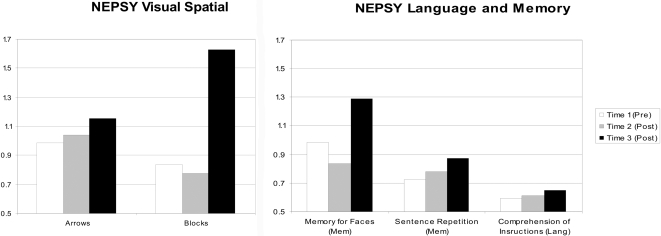
Rates of development for NEPSY subtests.A rate of “1” (vertical axis) indicates typical development (i.e., developmental age matches chronological age). A score of <1 indicates performance (developmental age) below that expected for chronological age.